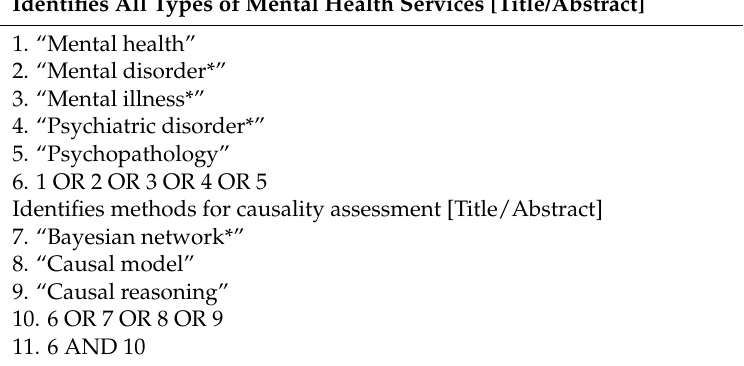
Table 2. Search strategy piloted in MEDLINE–PubMed version (First